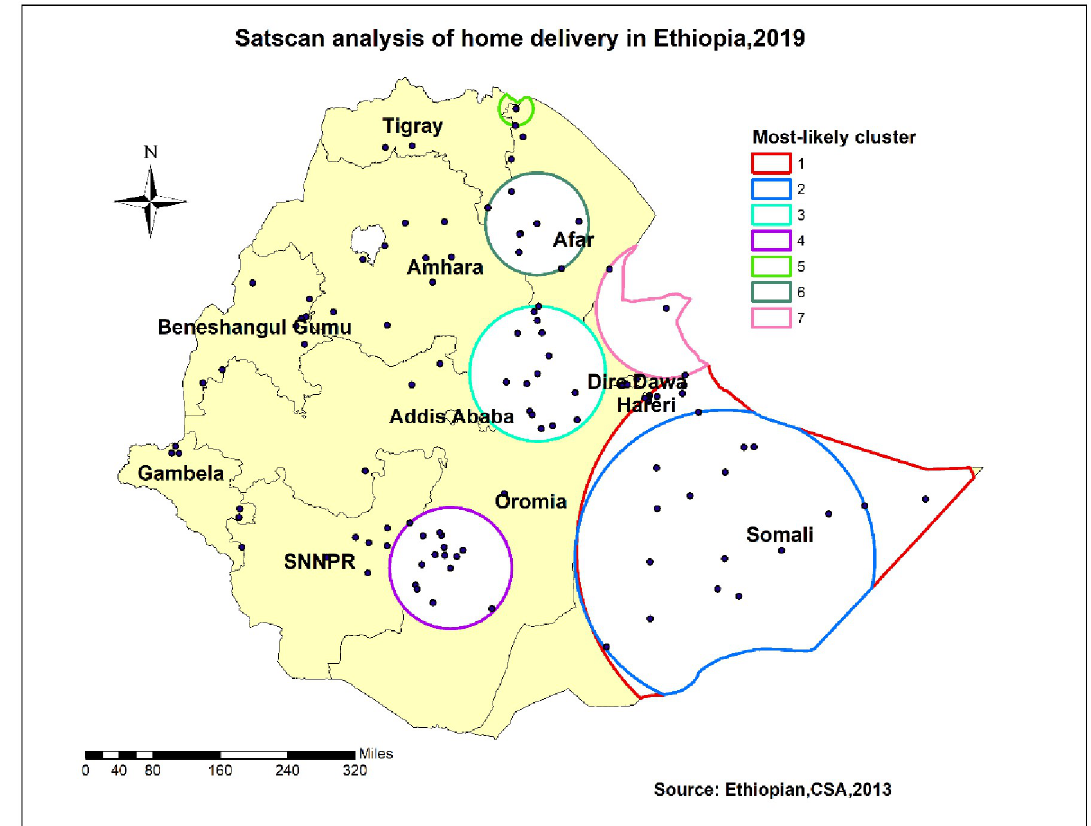
Fig 6. Spatial StatsCan analysis of home delivery in Ethiopia, 2019.